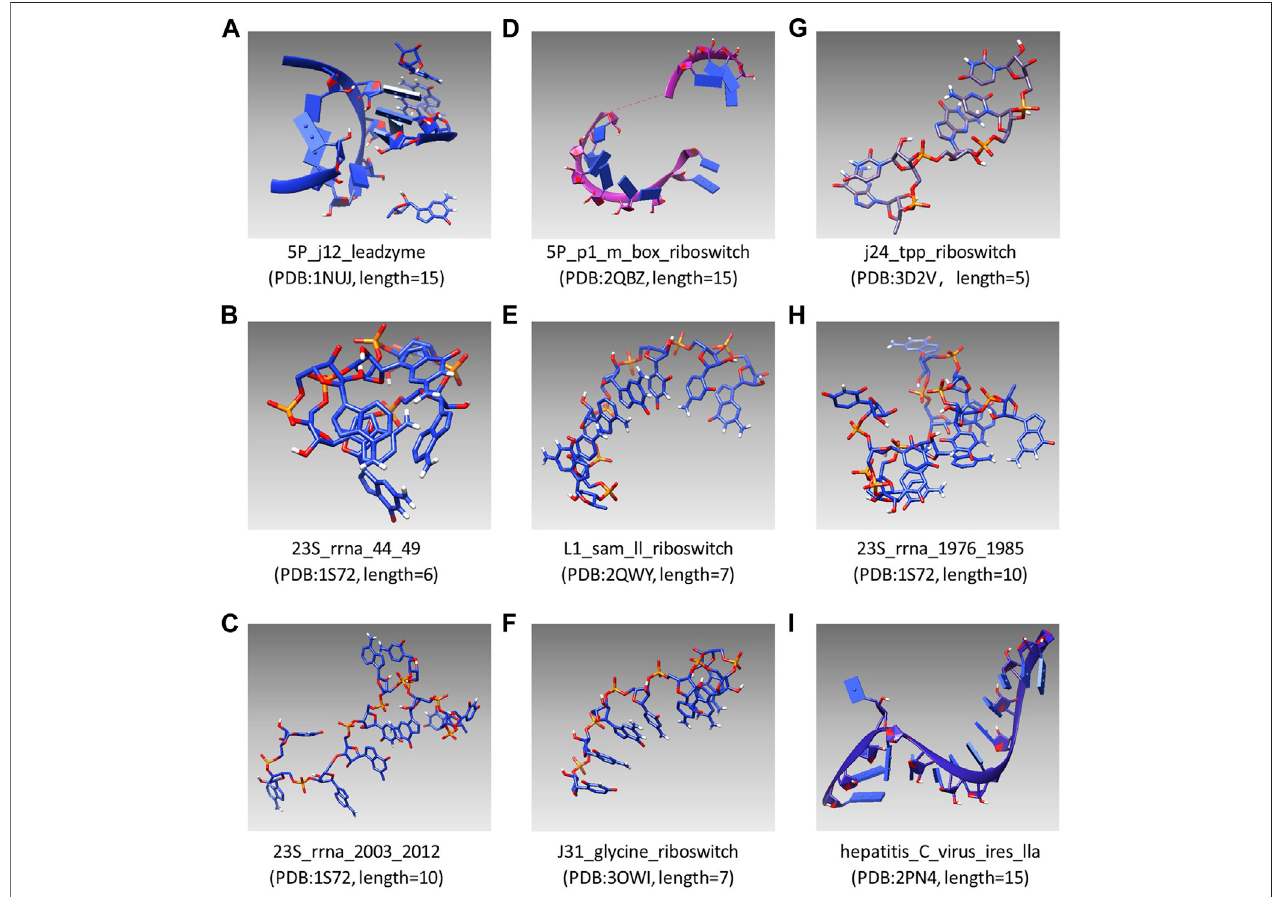
FIGURE 4 | Visual modeling results of the benchmark composed of nine RNA